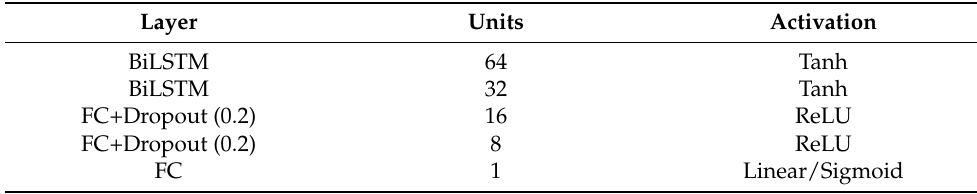
Table 1. Details of the model used for training.